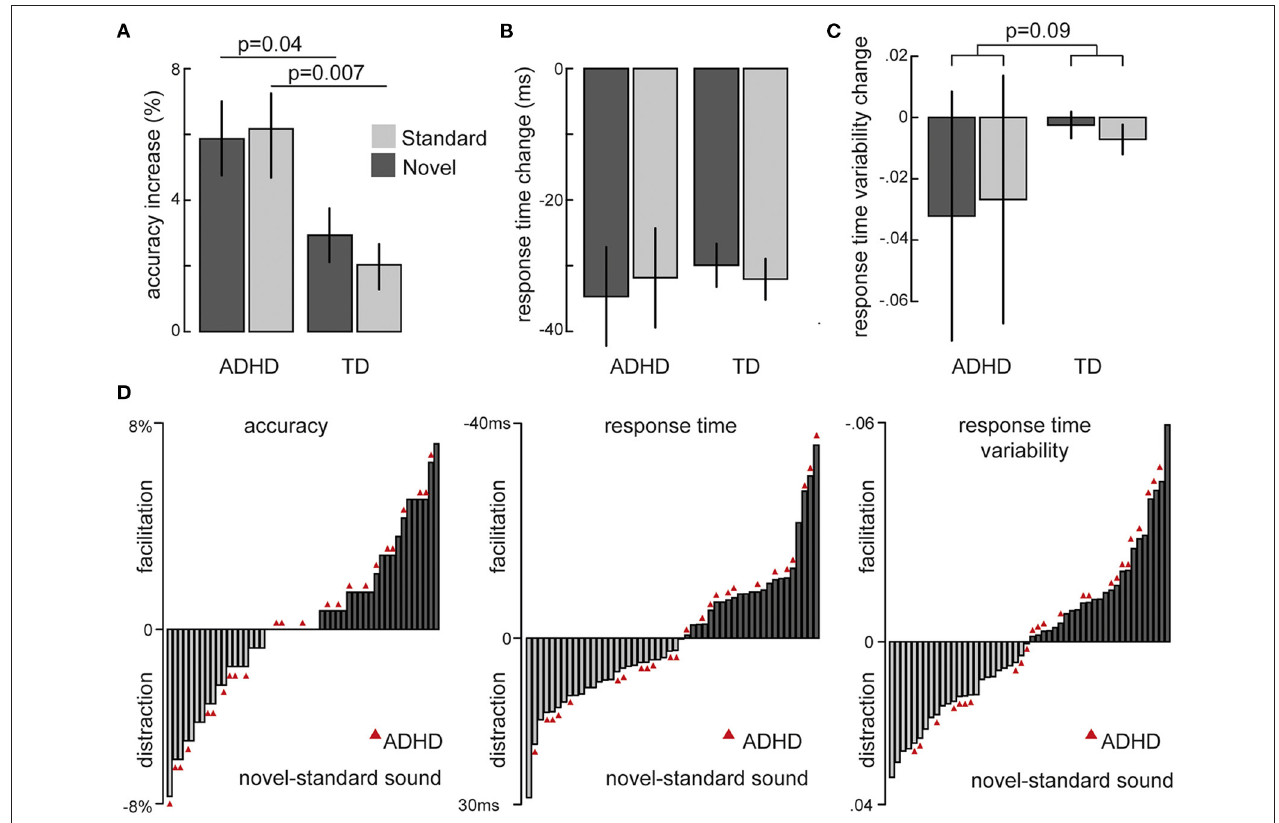
FIGURE 2 | Overview of sound-induced changes in behavior from the baseline without sound separately for children and adolescents with ADHD and typically developing peers (TD): (A) Overall accuracy (B) Mean reaction times (C) Coefficient of reaction time variability (SD/Mean). (D) Individual differences for changes by novel minus standard sounds in all measures of interest. ADHD participants are highlighted by red triangles.